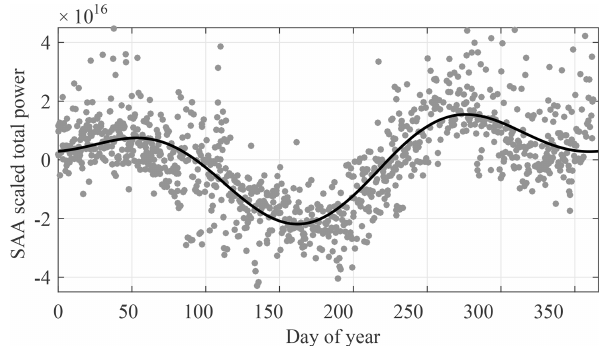
Figure 9. The SAA intensity changes over the course of a year (Schaefer et al., 2016).